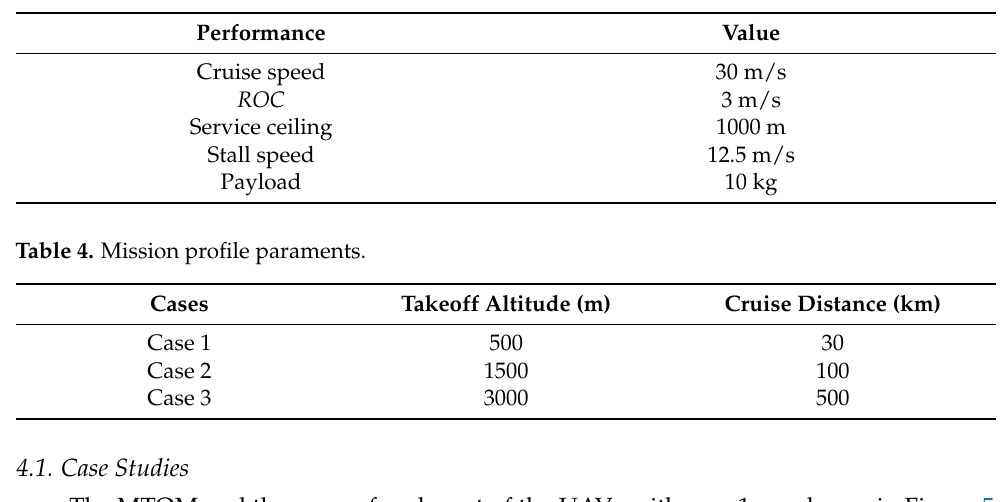
Table 3. Performance requirements.